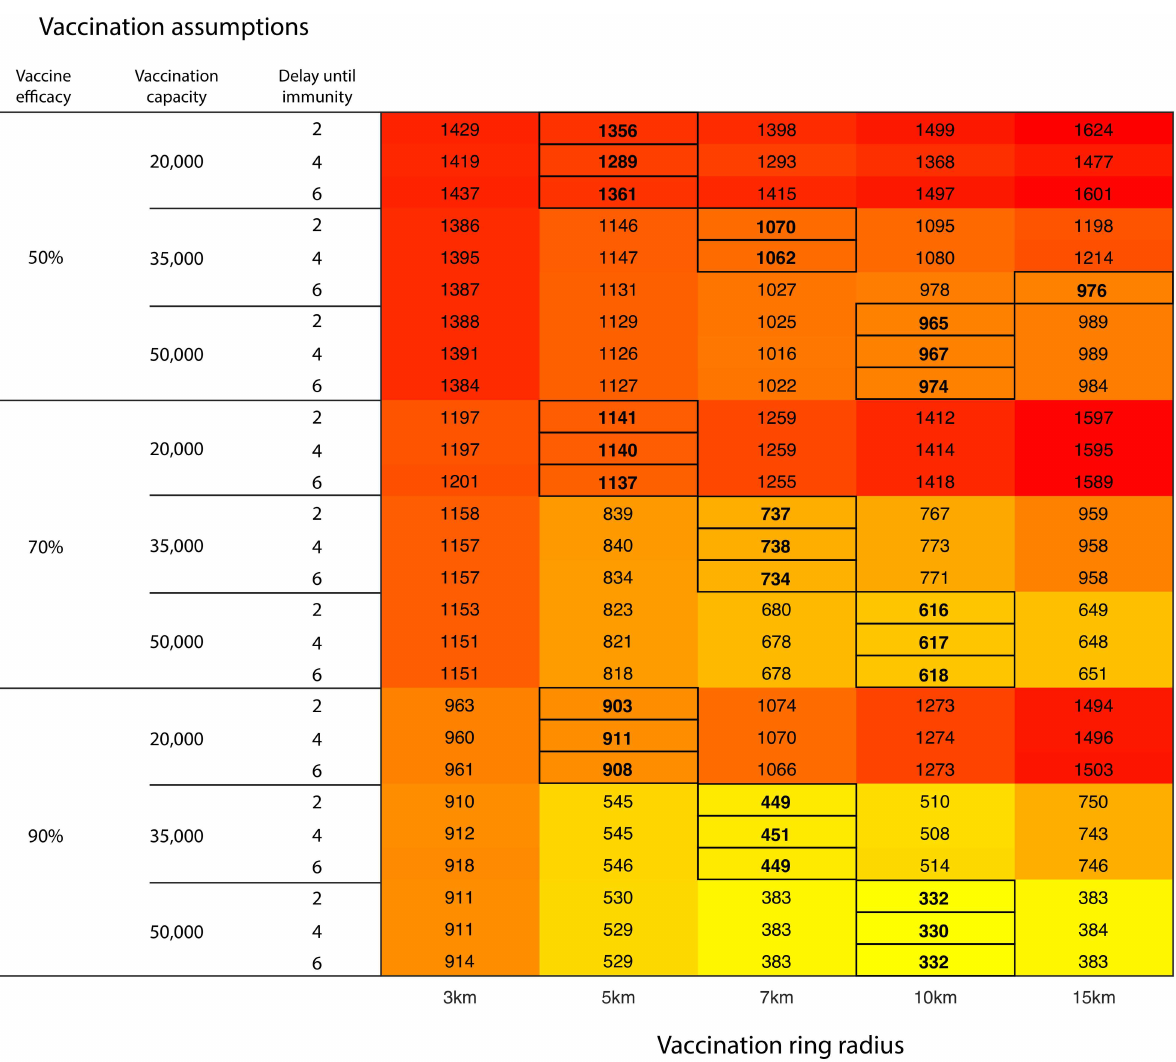
Fig 2. Projected mean outbreak cost (£million) under various vaccination ring radii (columns) and vaccination parameterisations (rows). Rows represent different combination of parameters regardingvaccinationefficacy, vaccination capacity (number of animalsvaccinated per day), and the delay (in days) from administering vaccination and conferral of immunity. Results have been presented roundedto the nearest integer value with the optimal strategy selectedprior to rounding.Outlinedvalues denote the optimalcontrol action for a given set of